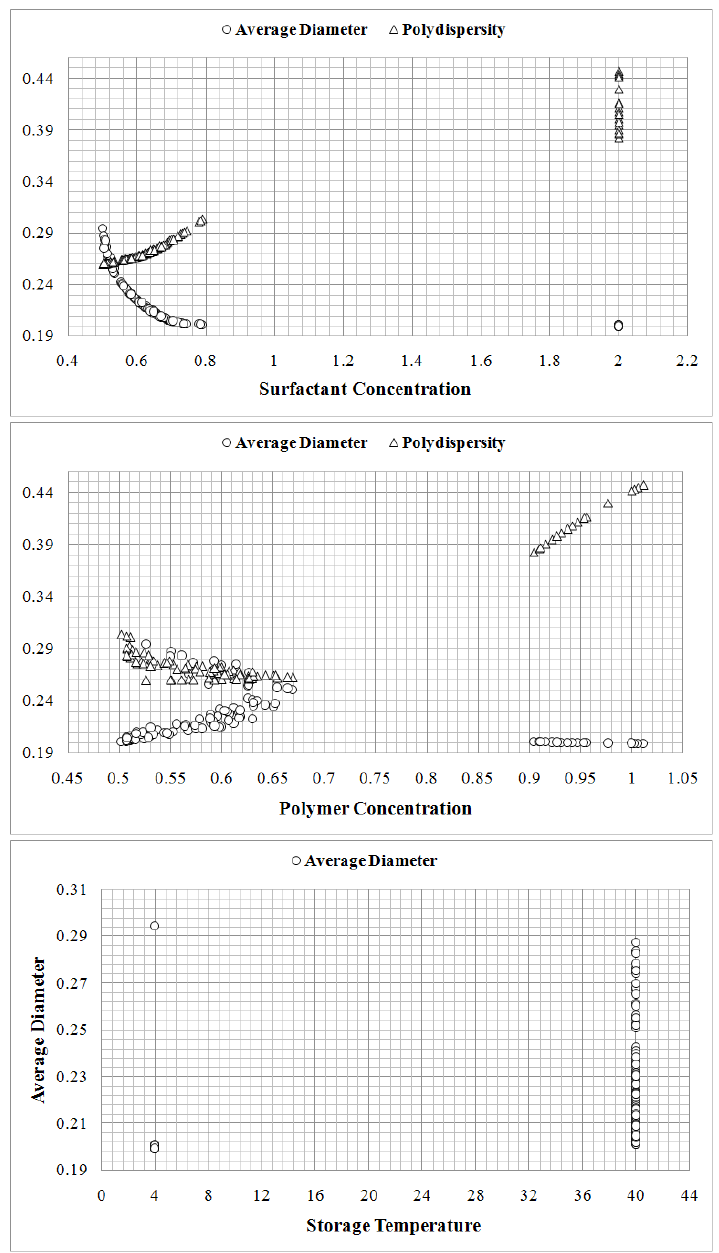
Figure 7. The optimal decision variables (surfactant concentration, polymer concentration, and storage temperature) corresponding to each point from the Pareto front obtained using NSGA-II-RJG with optimized parameter